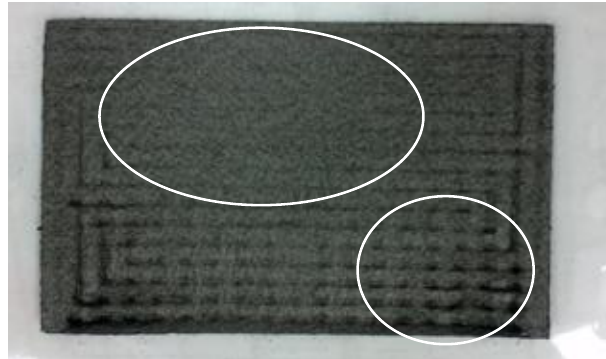
Figure 6. Surface indentation of GDL at R = 0.